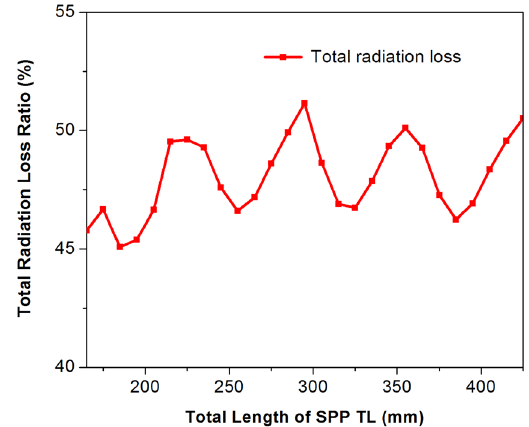
Figure 8. Relationship between radiation loss and length.